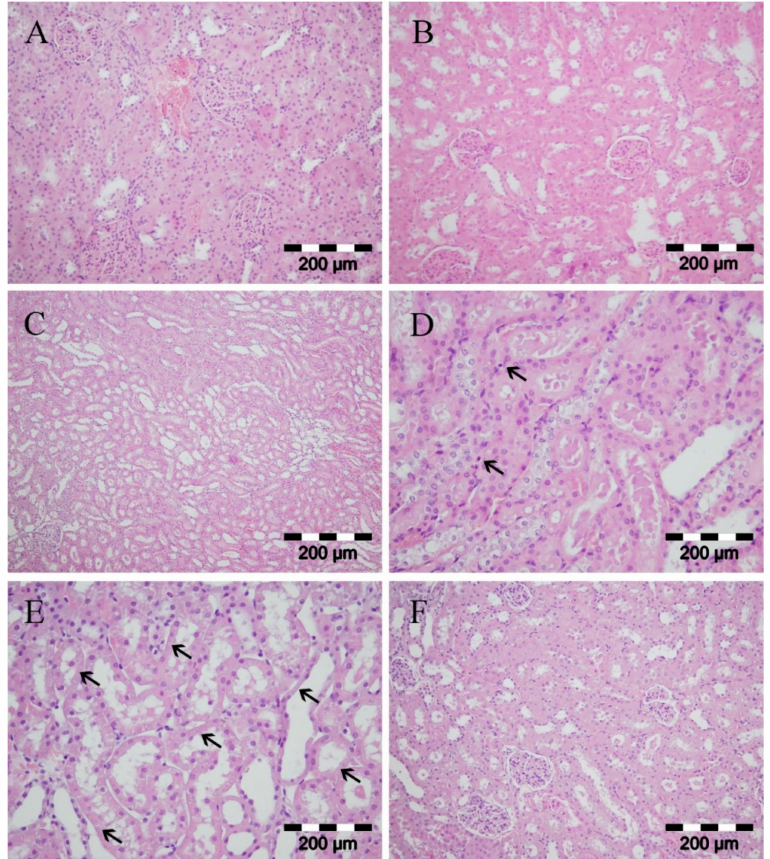
Figure 3. Kidney histology